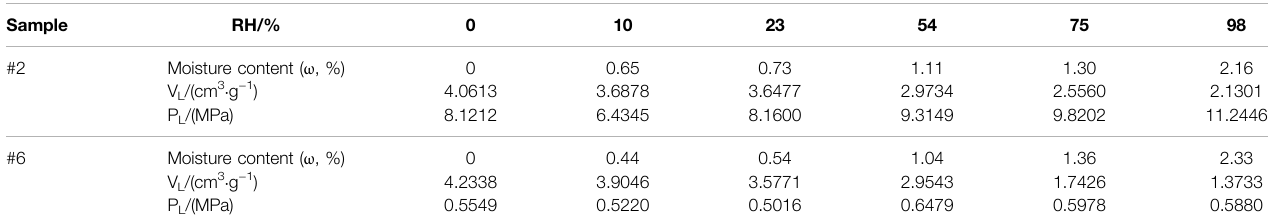
TABLE 6 | Moisture content and Langmuir adsorption constant of samples #2 and #6 with different humidity.